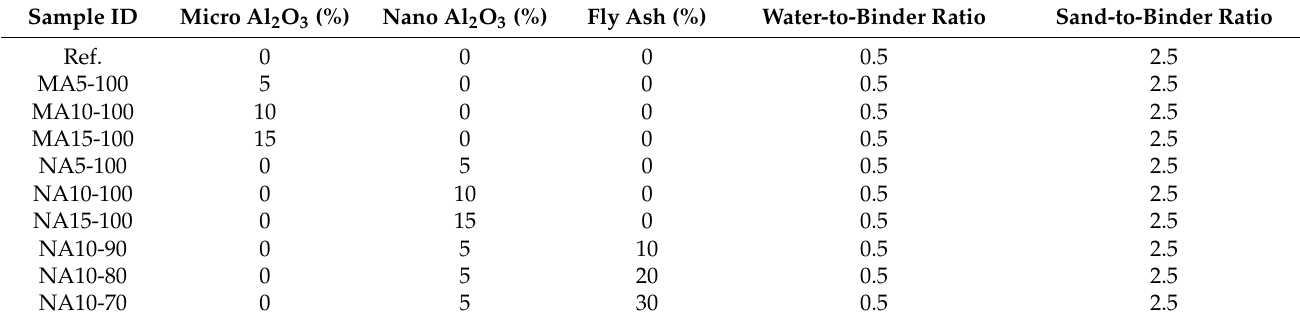
Table 1. Proportions of mixtures with different micro-Al 2 O 3 , nano-Al 2 O 3 and fly ash